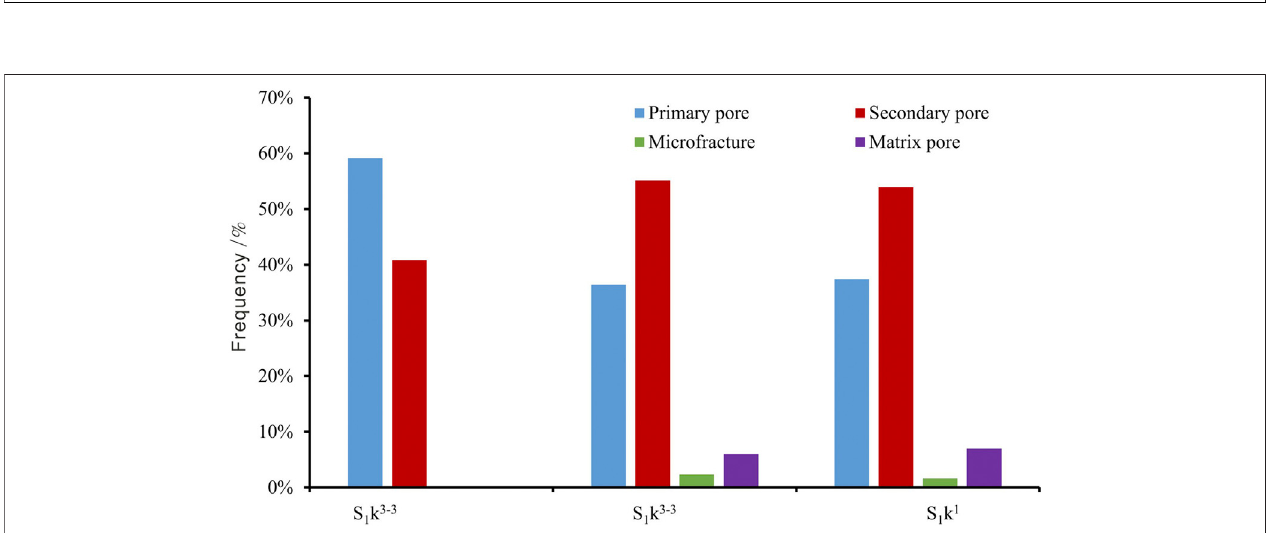
FIGURE 4 | Pore type distribution in different sandstone members of Kepingtage Formation.